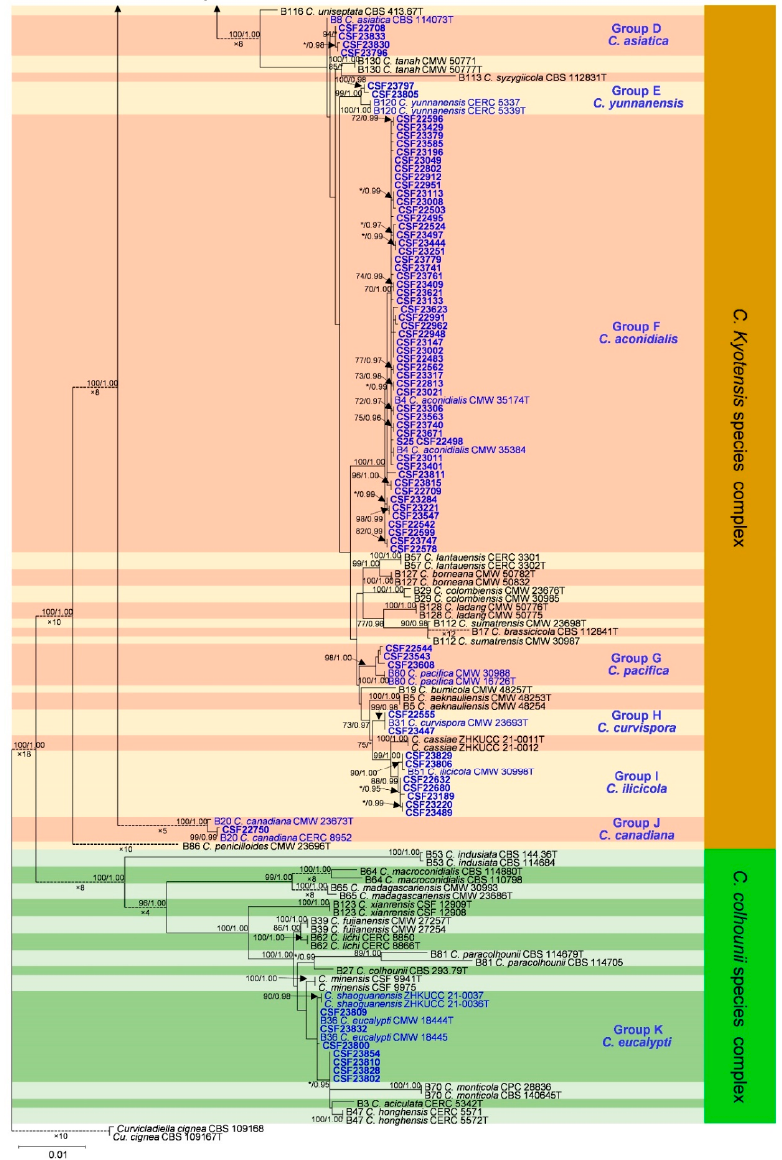
Figure 3. Phylogenetic tree of Calonectria species based on maximum likelihood (ML) analysis of the combined DNA dataset of act , cmdA , his3 , rpb2 , tef1 , and tub2 gene sequences. Bootstrap support values ≥ 70% from ML analysis and posterior probabilities values ≥ 0.95 obtained from Bayesian inference (BI) are indicated at the nodes as ML/BI. Bootstrap values < 70% or posterior probabilities values < 0.95 are marked with “*”, and absent analysis values are marked with “-”. “*/*”, “*/-”, “-/*”, and “-/-” are not displayed. Isolates obtained in this study are highlighted in blue and bold. Ex-type isolates are indicated with “T”. The “B” species codes are consistent with the recently published results of Liu and co-authors [30]. Curvicladiella cignea (CBS 109167 and CBS 109168) was used as the outgroup